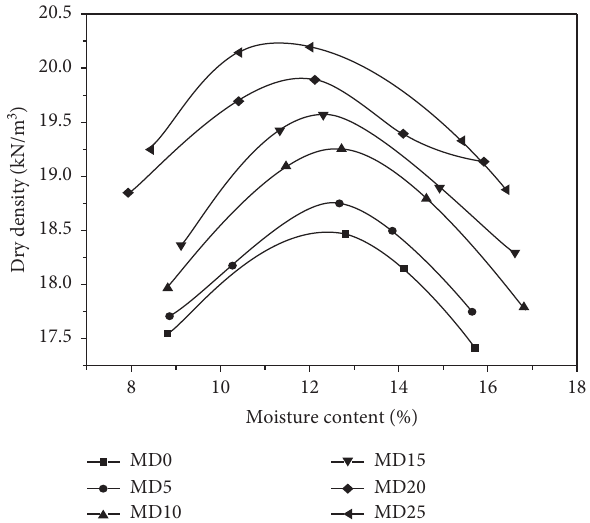
Figure 7: Relation between dry density and moisture content for UECS and